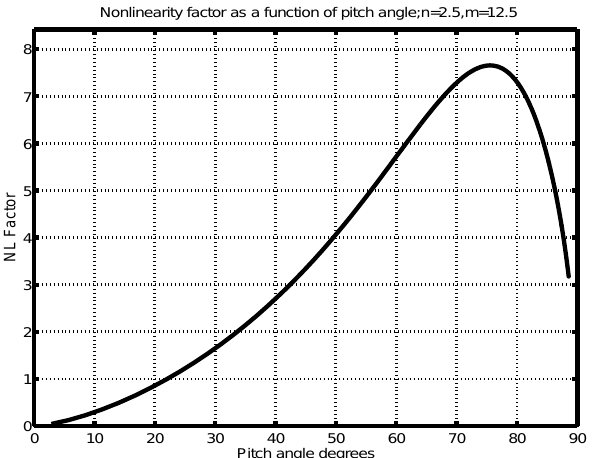
Fig. 4. Accumulated fractional contribution to the linear equatorial growth rate (dashed curve) and nonlinear growth rate (solid curve) at f = 10 . 2kHz, for the high anistropy “pancake” distribution. The nonlinear contribution is weighted by the size of the nonlinear trapping